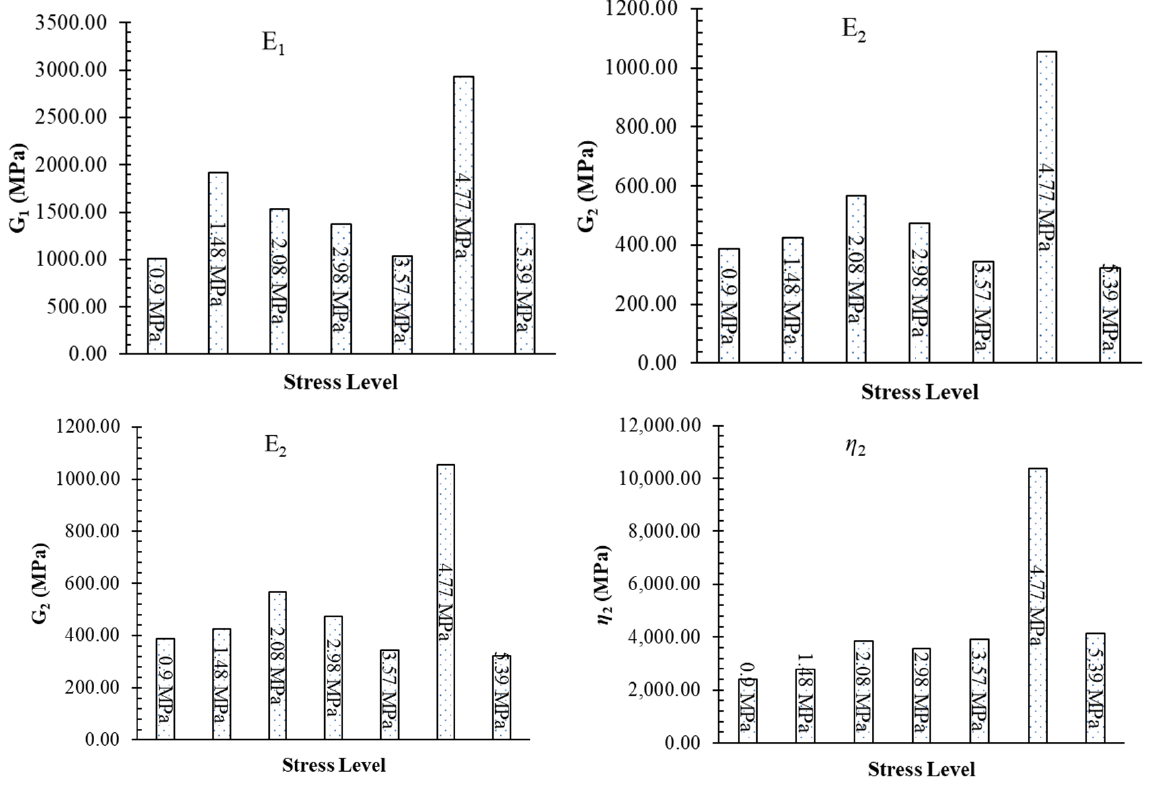
Figure 14. The rheological parameters based on different stress levels using ABC.